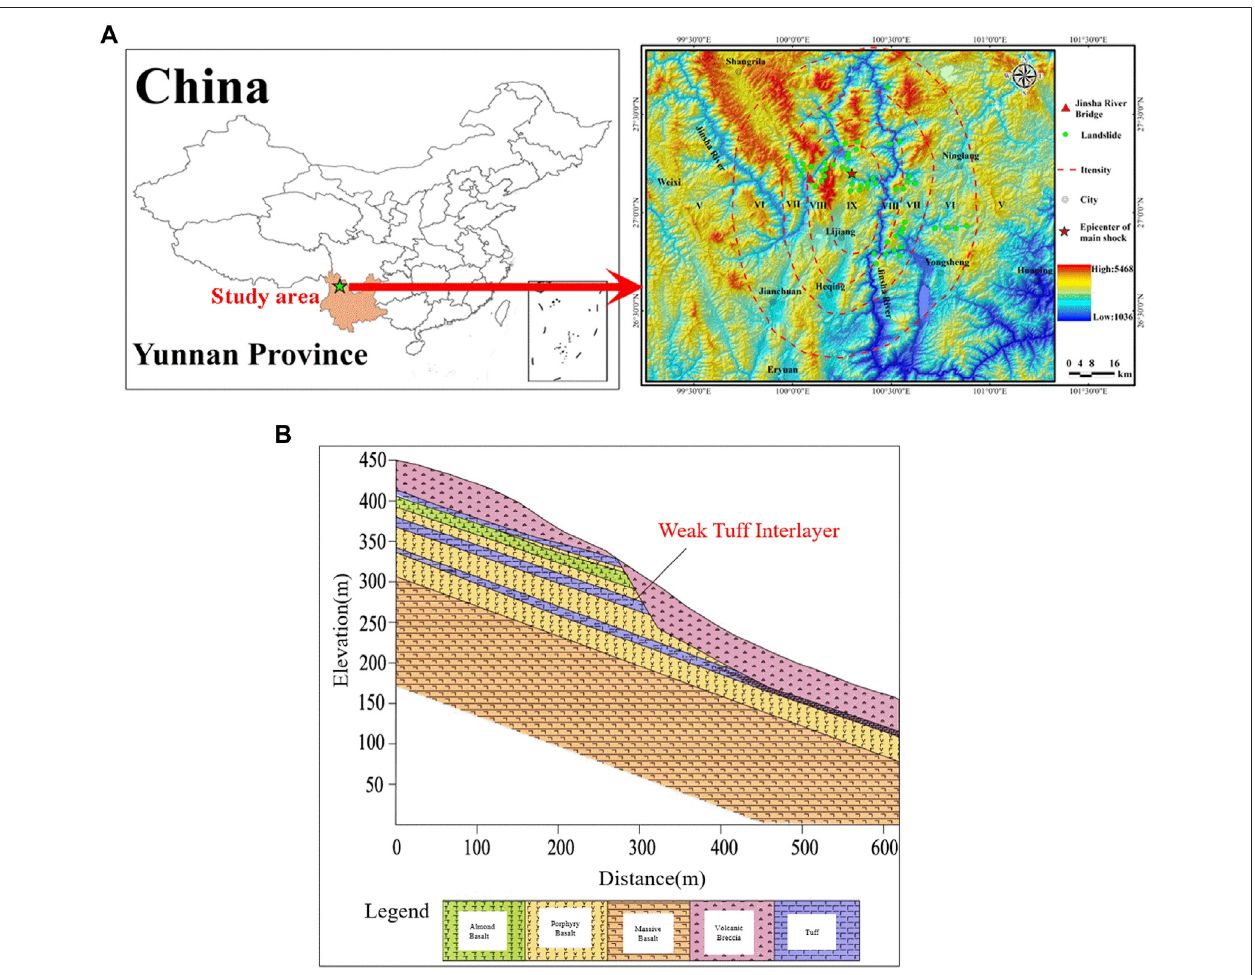
FIGURE 1 | (A) Location of the landslide, Yunnan Province, China, (B) The longitudinal geological pro fi le of the landslide.